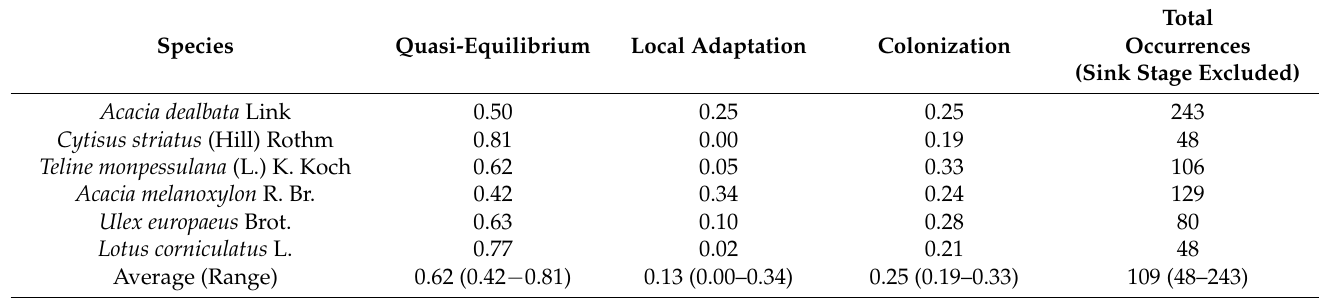
Table 1. Proportion of plant populations falling within the three invasive stages proposed by [14] for six alien leguminous